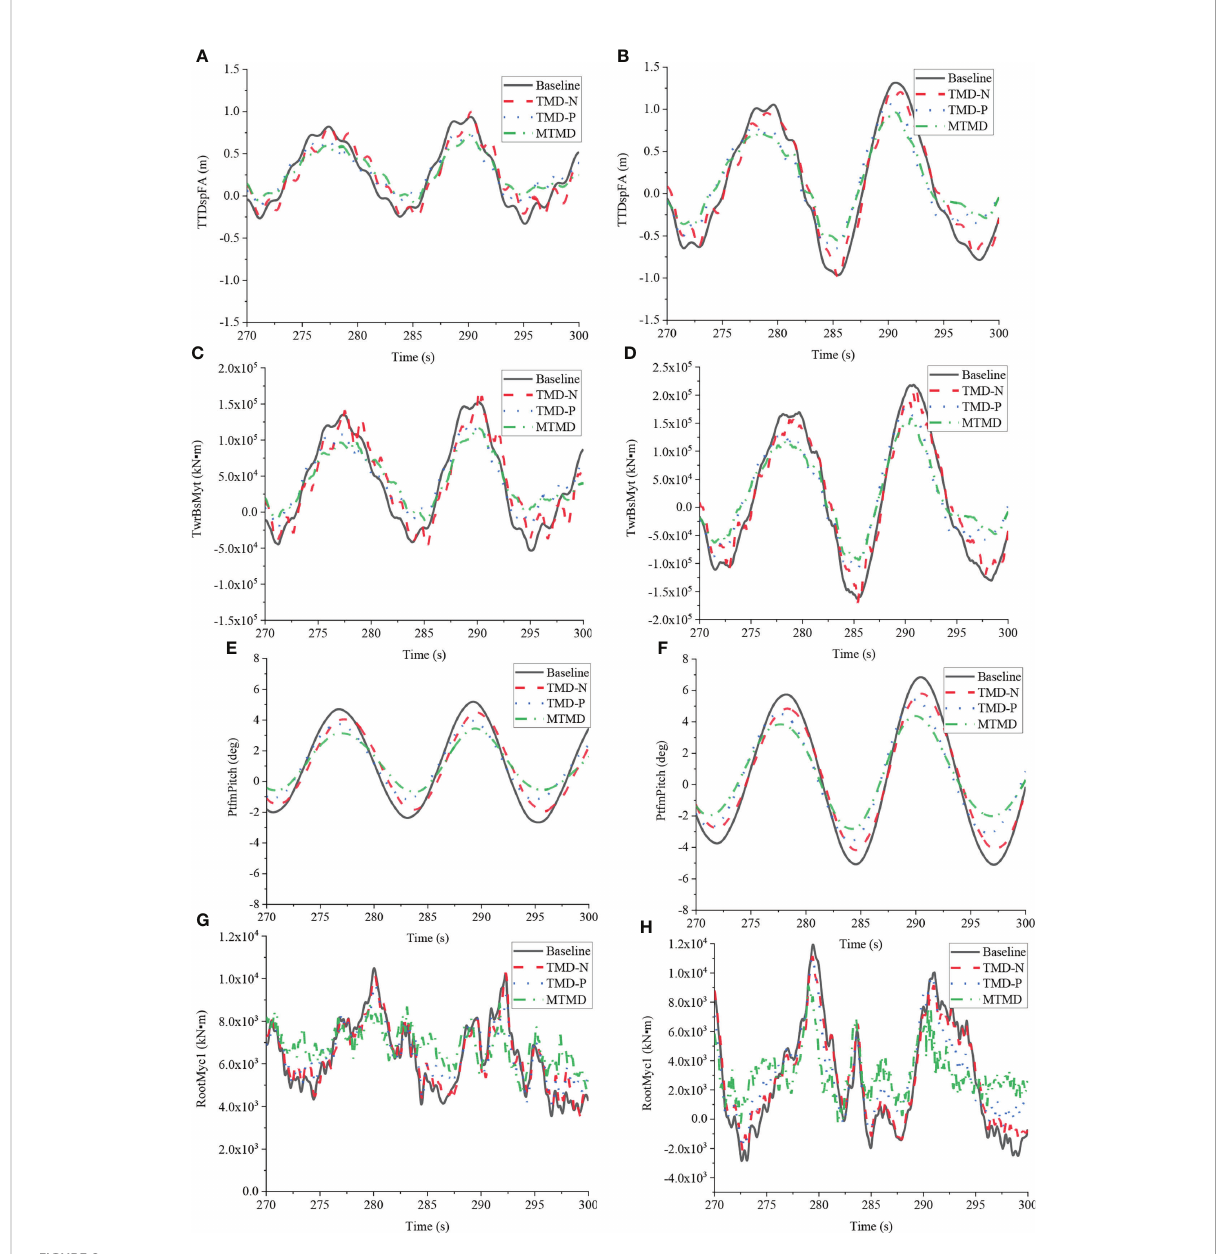
FIGURE 9 Reduced histories of the barge FOWT under the typical winds and waves using the optimized TMDs and MTMD. (A) Histories of tower top displacement under load case 2; (B) Histories of tower top displacement under load case 4; (C) Histories of tower base bending moment under load case 2; (D) Histories of tower base bending moment under load case 4; (E) Histories of platform pitch motion under load case 2; (F) Histories of platform pitch motion under load case 4; (G) Histories of fl apwise bending moment at blade root under load case 2; (H) Histories of fl apwise bending moment at blade root under load case